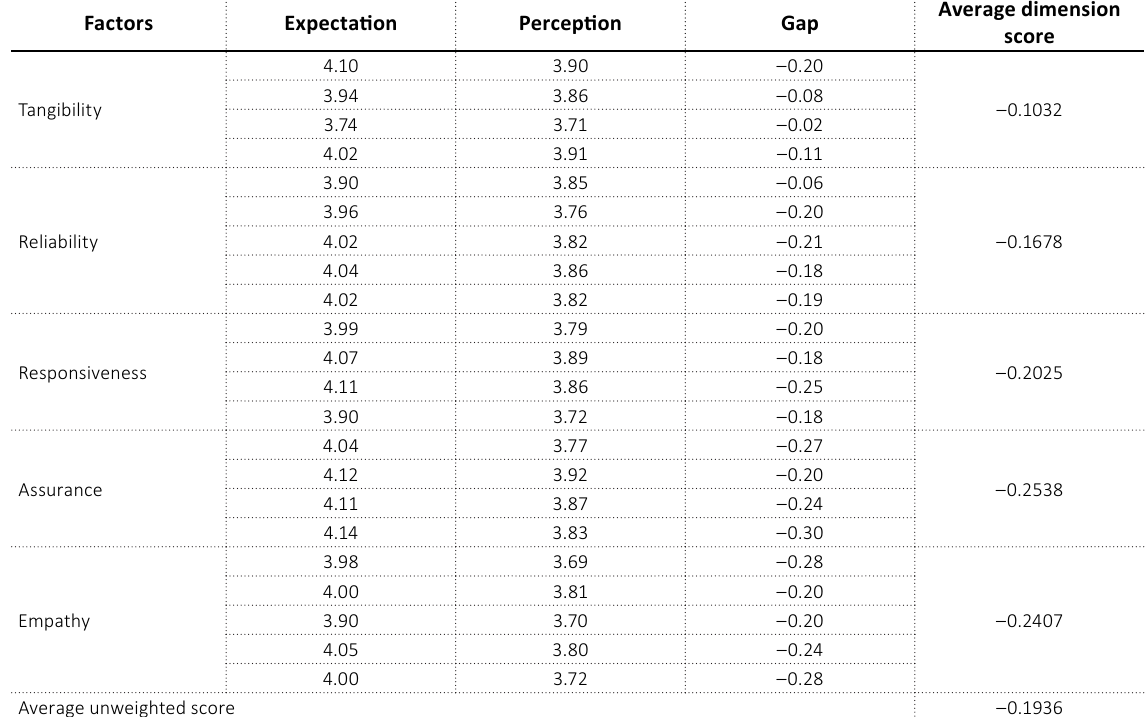
Table 7. Gap analysis between expectations and